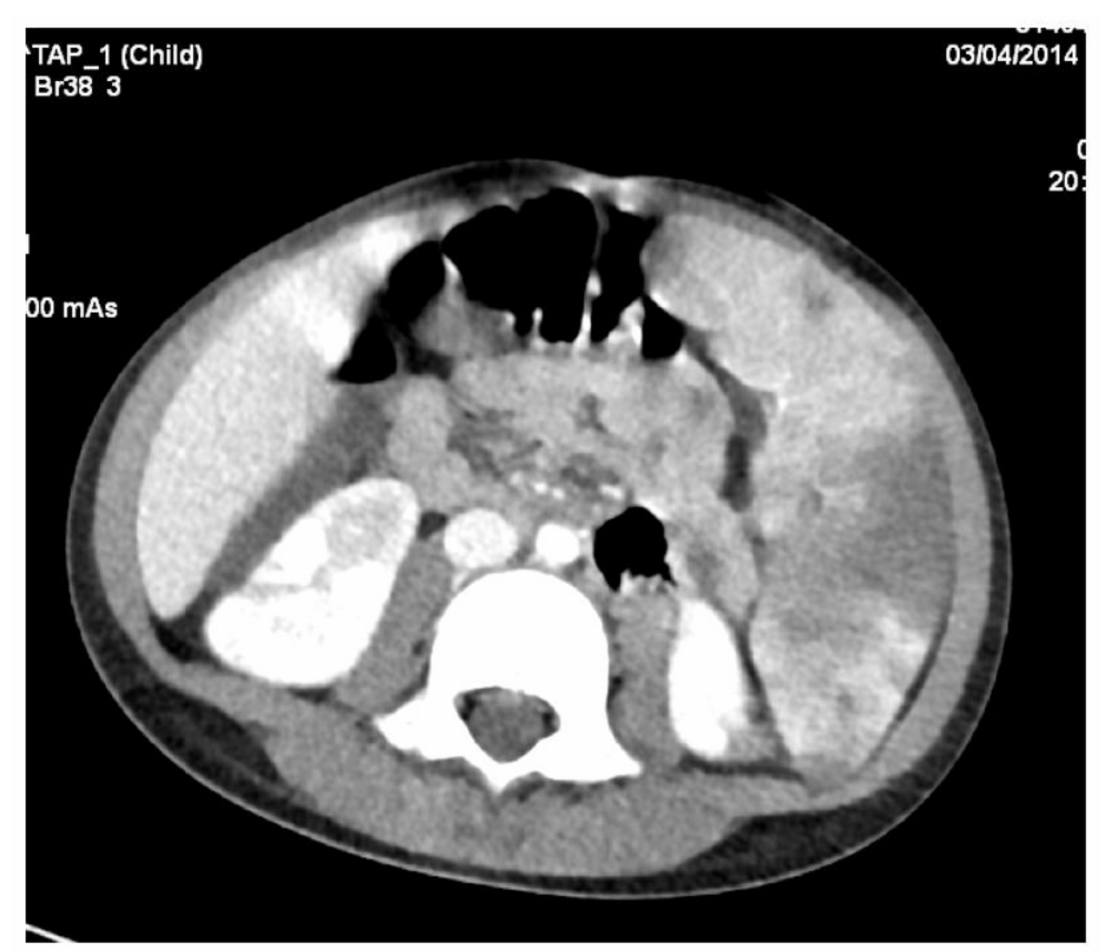
Figure 9. Abdominal angioCT shows multiple infarctions at the kidneys and spleen level. Emergency cardiac surgery for mitral and tricuspid valves was performed. An exten- sive cardiac surgical intervention was initiated with the excision of massive vegetations of the mitral valve (Figure 10) and shaving of the tricuspid valve. Mitral valve replace- ment was required and it was performed with CarboMedics prosthesis. Unfortunately, the patient did not survive in the following hours, manifesting severe hypotension on the back- ground of severe cardiac dysfunction and vasoplegic shock in the context of fungal sepsis, despite the maximum inotropic and vasoactive treatment. The cultures performed from the vegetation yielded filamentous fungi, which presented macroscopic morphological characteristics and microscopic characteristics of the order Mucorales, Cunninghamella spp. Additionally, a polymerase chain reaction (PCR) performed from the vegetations revealed Cunninghamella spp. as the etiology of the